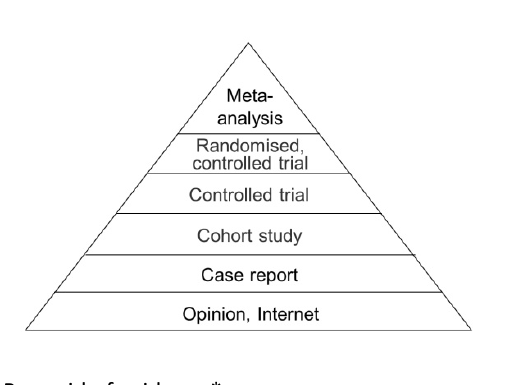
Table 2: Results of a survey among students regarding the explanatory power of two metaphors representing the levels of evidence (n = 100)